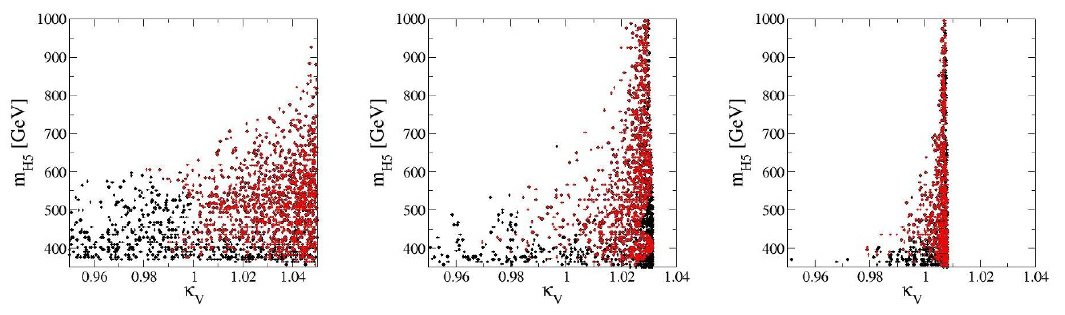
Figure 9 . Black (red) dots are allowed only by Bound A (by both Bound A and the LHC data) in the GM model. The value of tan β is taken to be 3, 5 and 10 on the left, center and right panels, respectively. We take m = m . All the other parameters ( m H 3 H 5 m 350 H 1 ≥